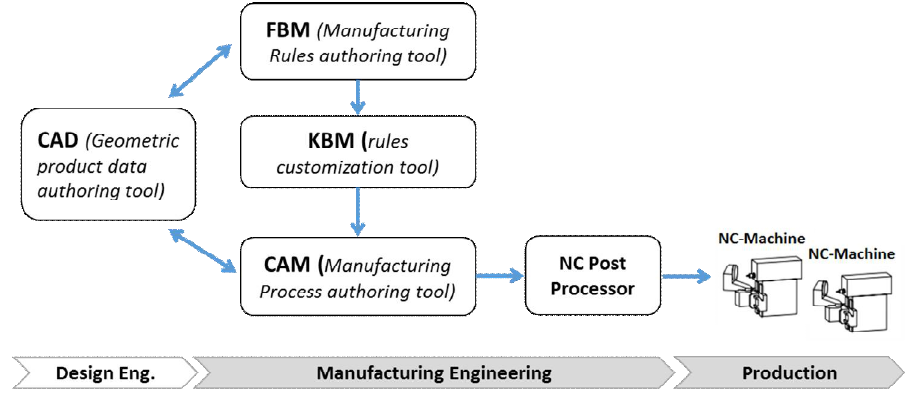
Figure 6. KBM technological scenario.